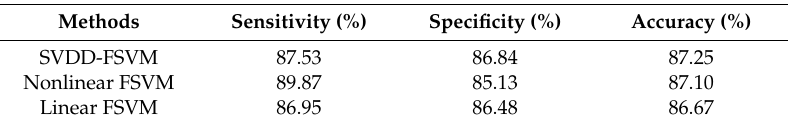
Table 2. Performance on the Australian test data set.